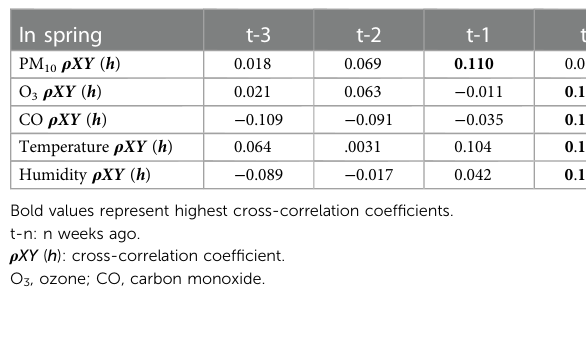
TABLE 5 Cross-correlation coef fi cients between the number of asthma exacerbations (t) and atmospheric substance (t-n) in winter. In winter